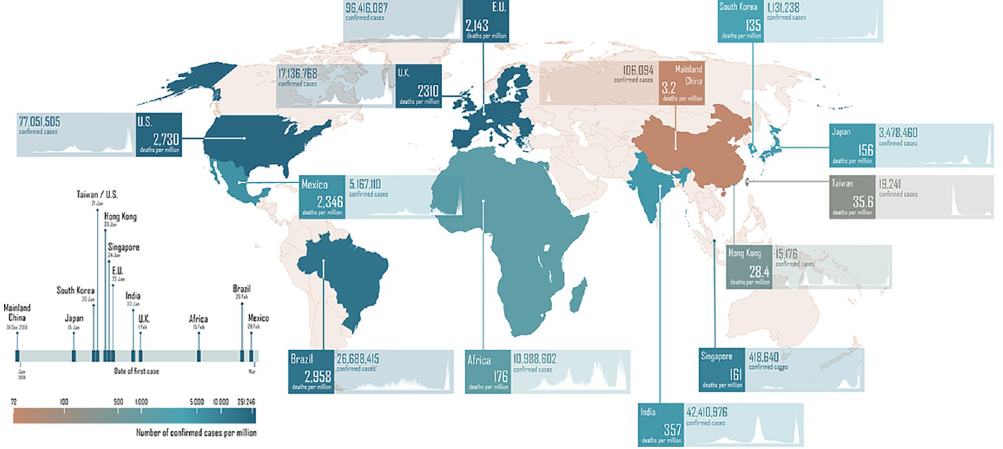
Fig 1. Comparative COVID-19 burden of disease as at January 11, 2022. (The map is in the public domain: https:// commons.wikimedia.org/wiki/File:BlankMap-World.svg). COVID-19, Coronavirus Disease 2019.